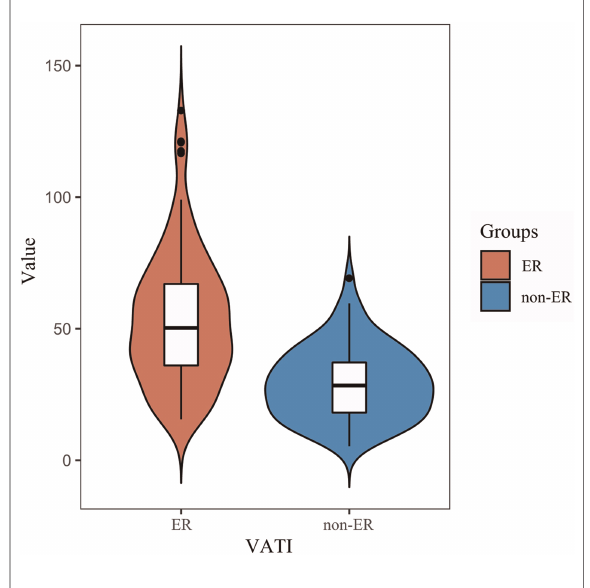
FIGURE 3 Comparison of the VATI between the ER and non-ER groups. An increase in visceral adipose tissue index (VATI) value was associated with an increased risk of early recurrence.